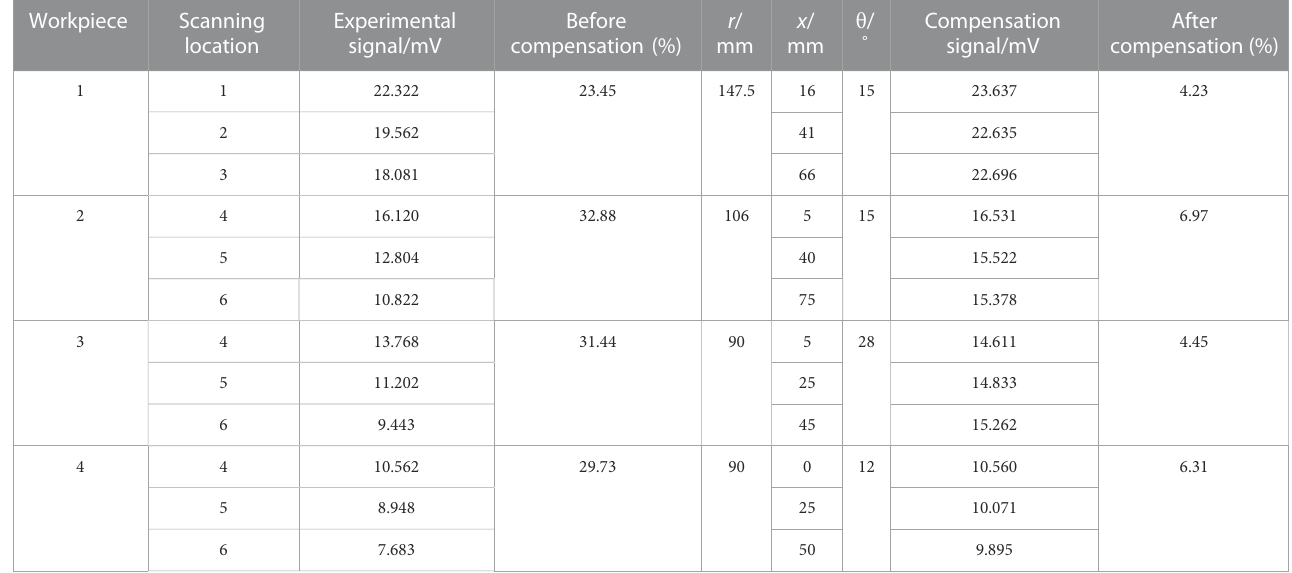
TABLE 4 Relative changes in the experimental signal amplitude before and after compensation.